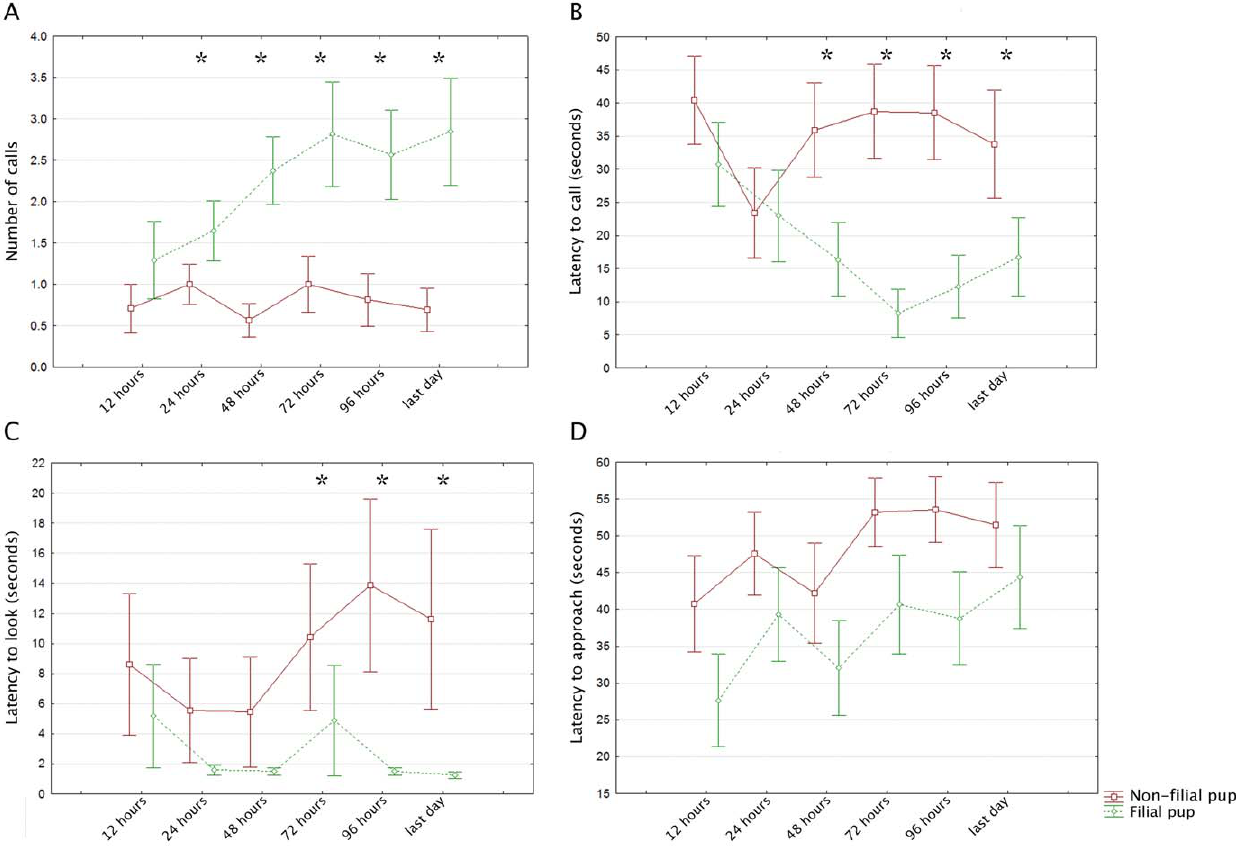
Figure 3. Comparisons of female responses within behavioural measures. A. Females call more in response to playback of their filial pup’s and a non-filial pup’s FACs within 24 hours of birth. See table 2, points=mean 6 1 S.E.M. * indicates significant difference. B. Within 48 hours of birth, females call sooner to the FAC of their filial pup than they do to the FAC of a non-filial pup. See table 2, points=mean 6 1 S.E.M. * indicates significant difference. C. By 72 hours after birth females look more rapidly to their filial pup’s FAC than to a non-filial pup. See table 2, points=mean 6 1 S.E.M. * indicates significant difference. D. Females did not show a significant difference in their latencies to approach following playback of the FAC of their filial pup or a non-filial pup. See table 2, points=mean 6 1 S.E.M.